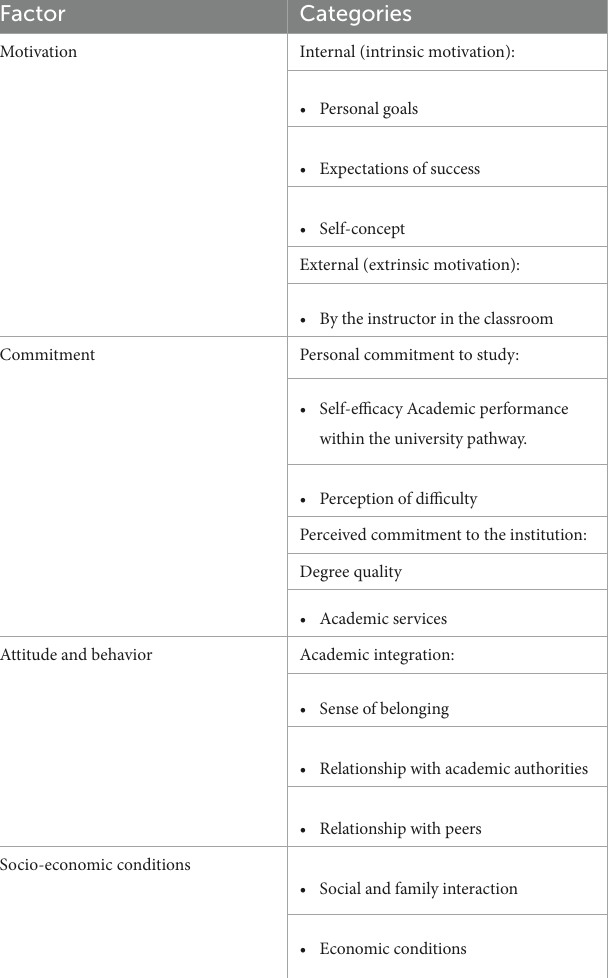
TABLE 3 Factors and categories of student permanence in the university persistence survey. Factor